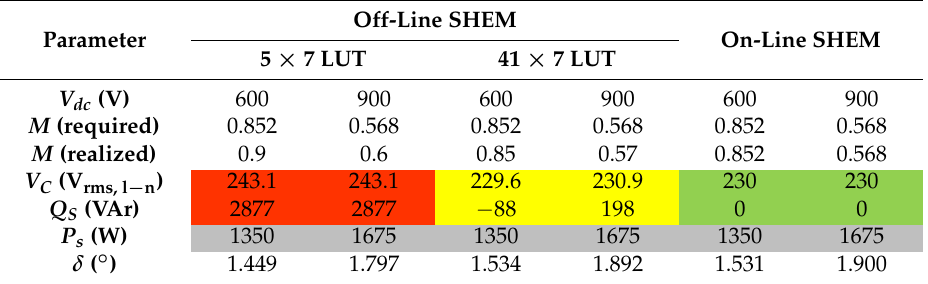
Table 1. Errors in Reactive Power Adjustment Arising From Off-line SHEM Based on the Look-Up Table (LUT) Method for Unity Power Factor (PF)